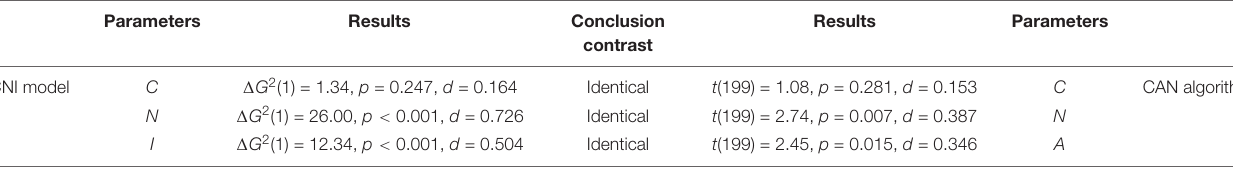
TABLE 1 | Test of gender differences with the CNI model and CAN algorithm in Study 1a by Gawronski et al. (2017). Parameters